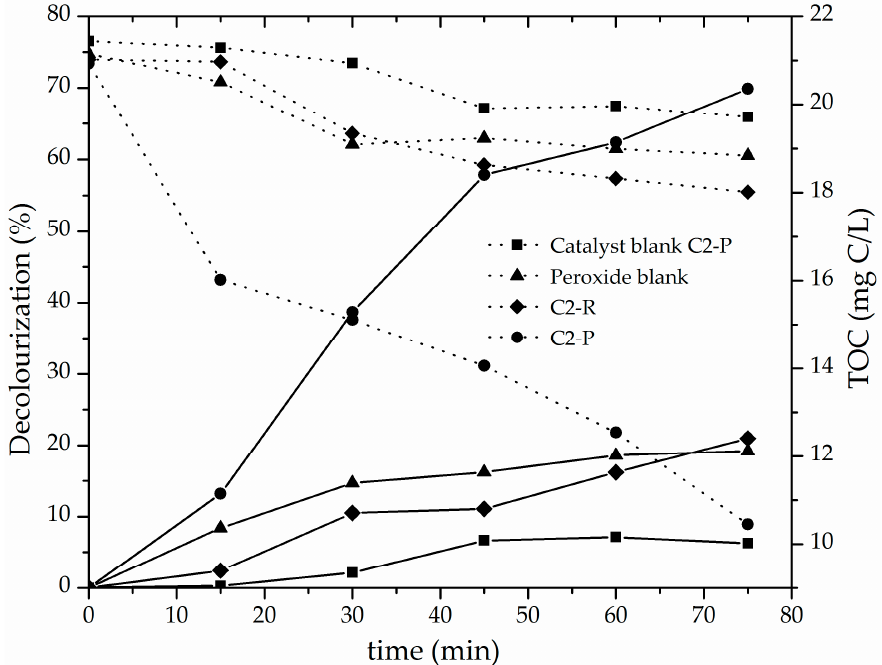
Figure 8. Decolourization (solid lines) and TOC concentration (dotted lines) shown by refined and pillared forms of C2 material in the CWPO degradation of methyl orange: Catalyst loading = 0.05 g/L; [MO] 0 = 0.119 mmol/L; [H 2 O 2 ] added = 51.2 mmol/L, V added = 100 mL; H 2 O 2 stepwise addition = 100 mL/h; pH = 3.4; T = 25 ± 0.1 °C; ambient pressure = 0.76 atm.